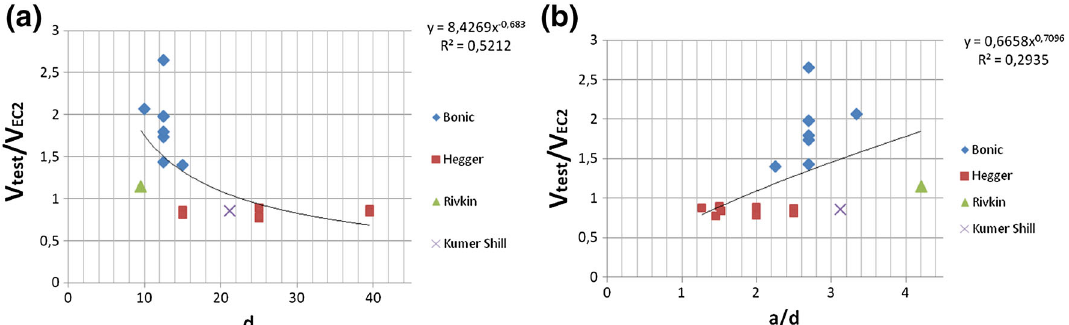
Fig. 17 Comparison of the results of the punching tests and punching capacity according to Eurocode 2 regarding: a effective depth ( d ); b shear slenderness of the footing ( a / d ).